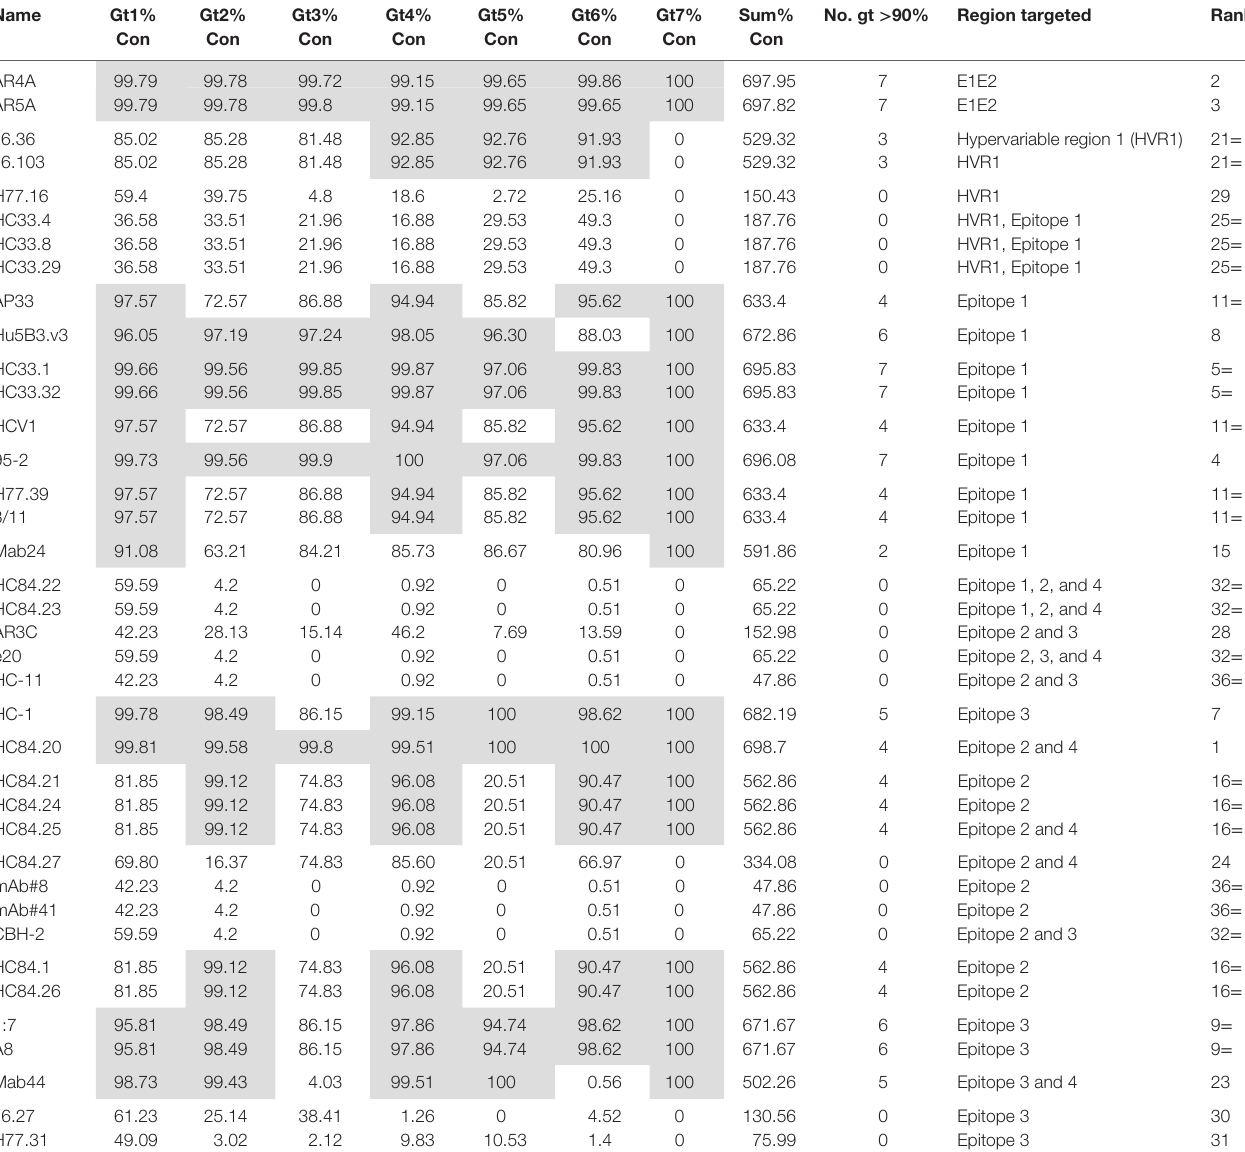
TaBle 2 | The lowest conservation (%) for each bNAb epitope binding motif across genotypes. name